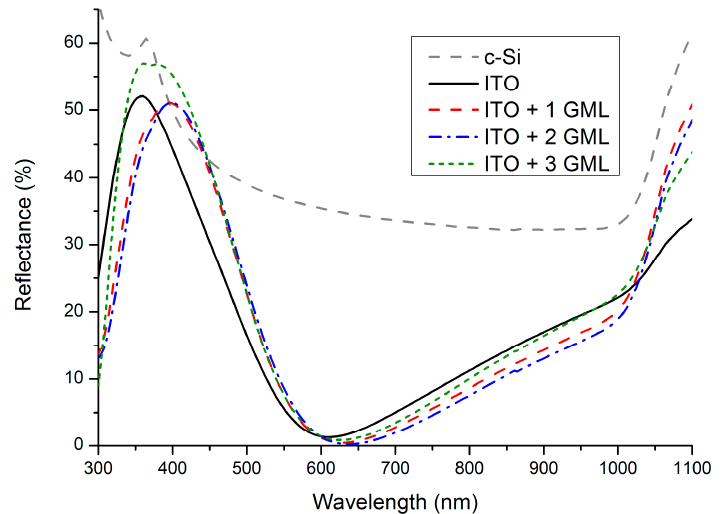
Figure 3. Reflectance spectra measured for the cells with only ITO as the TCE and the cells with a hybrid TCE consisting of a layer of ITO and either one, two, or three graphene monolayers. The reflectance spectrum of a bare polished silicon wafer is also shown for reference.